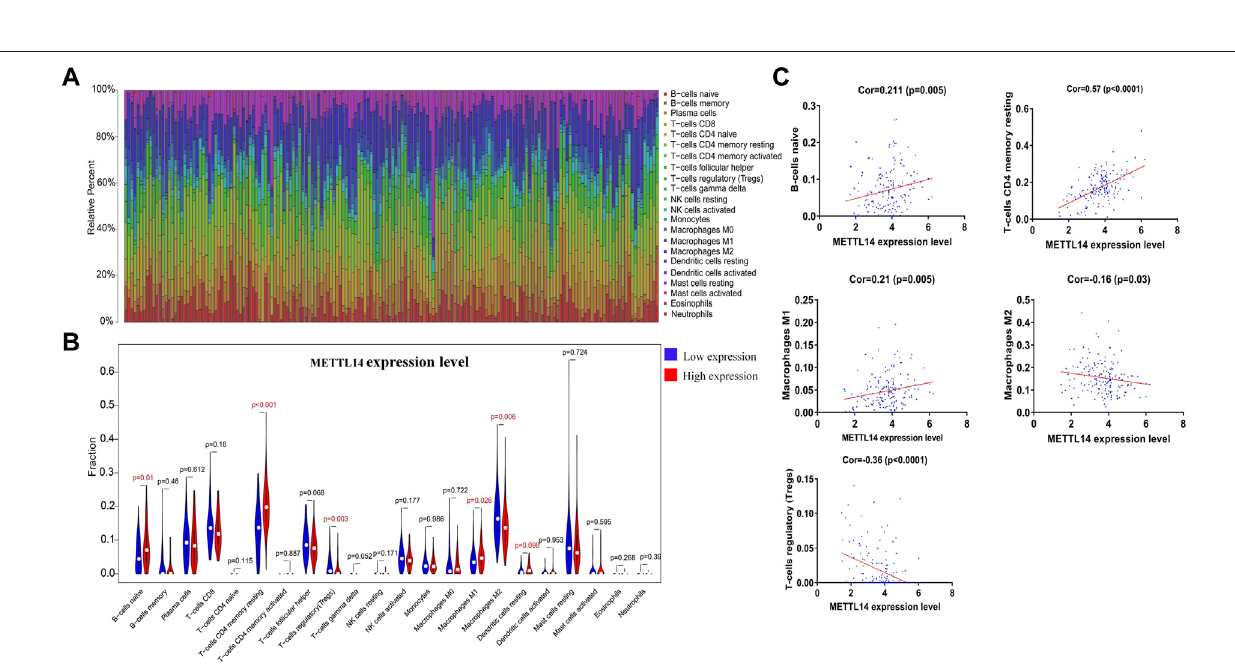
Frontiers in Genetics |